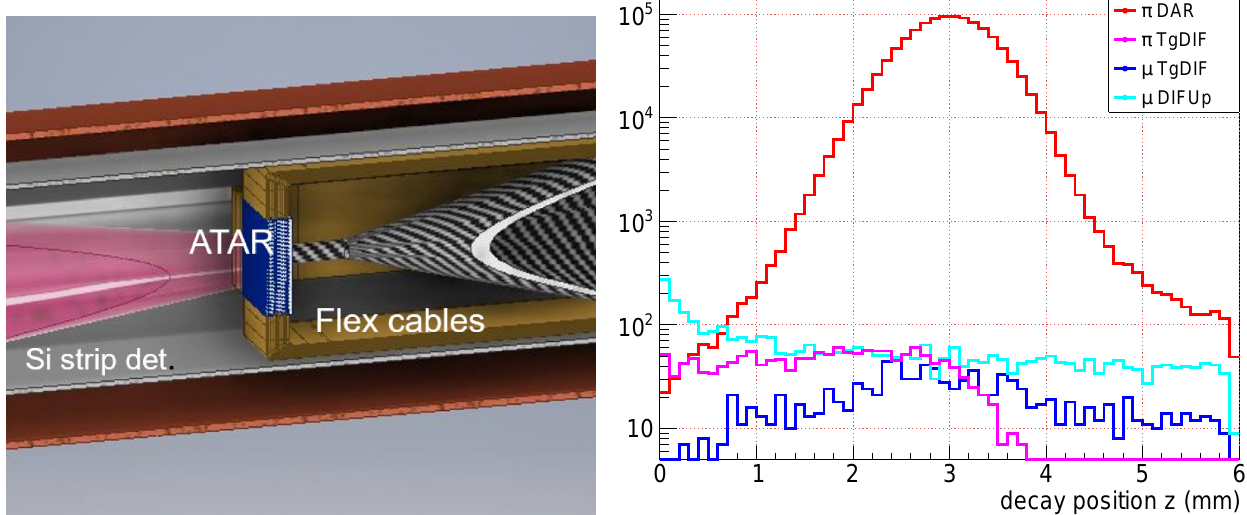
Figure 2. ( Left ) Position of the ATAR on the beam line. ( Right ) Simulated pion and muon decay positions along the beam direction (Z) for decay at rest (DAR), decay in flight in the target (TgDIF), and decay in flight upstream of the target (DIFUp). Decay in flight is a potential source of systematic effects, which are currently under study.